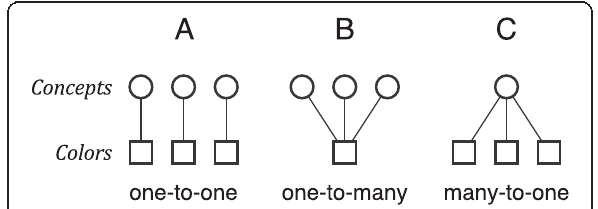
Figure 1 Mappings between colors ( squares ) and concepts ( circles ) that are a one-to-one, b one-to-many, and c